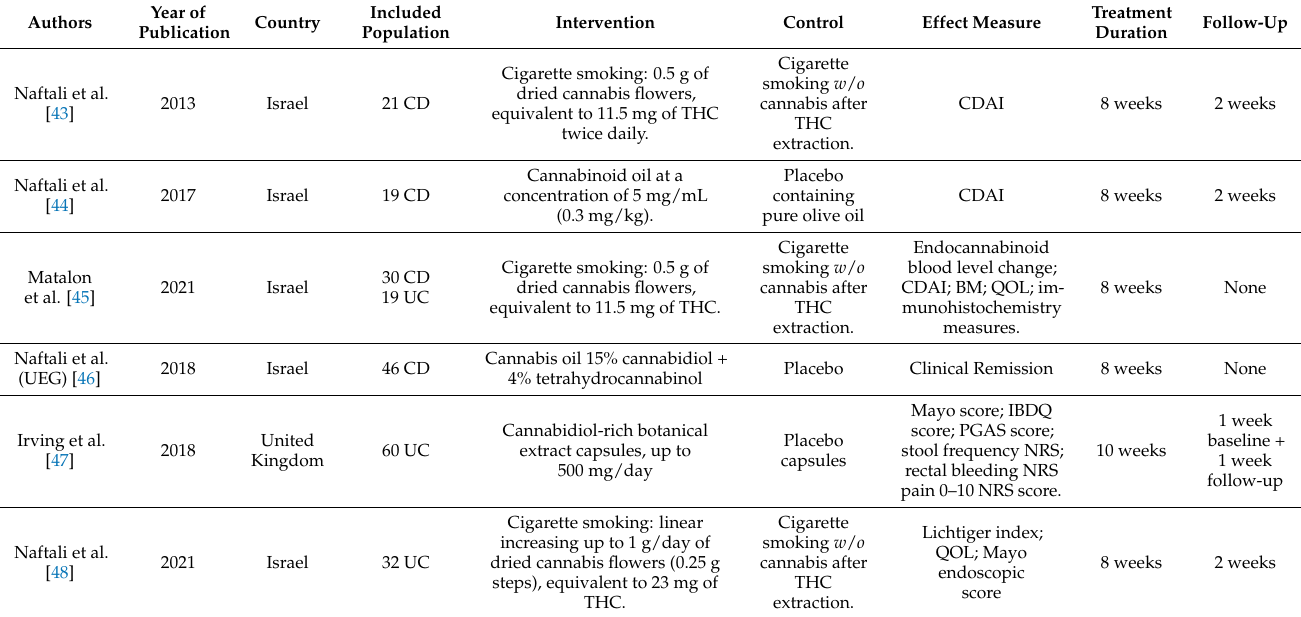
Table 3. Characteristics of included studies according to GRADE recommendations.